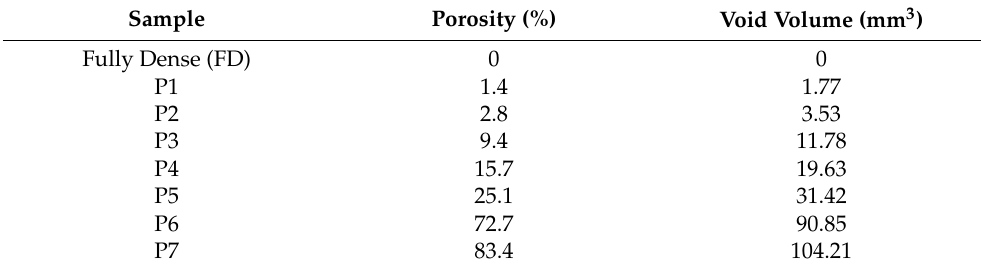
Figure 7. Porous structure designs showing the different types of cavities used; P1 to P5 varying degrees of cylindrical cavities; P6—enclosed honeycomb structure; and P7—lattice structure with 14-spokes per unit cell. Table 2. Levels of porosity considered in the study; a fully dense cube volume is 125 mm 3